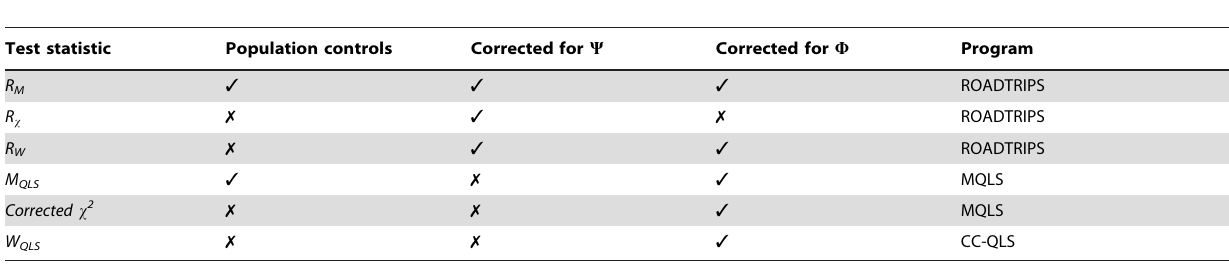
Table 1. Summary of the test statistics used in the